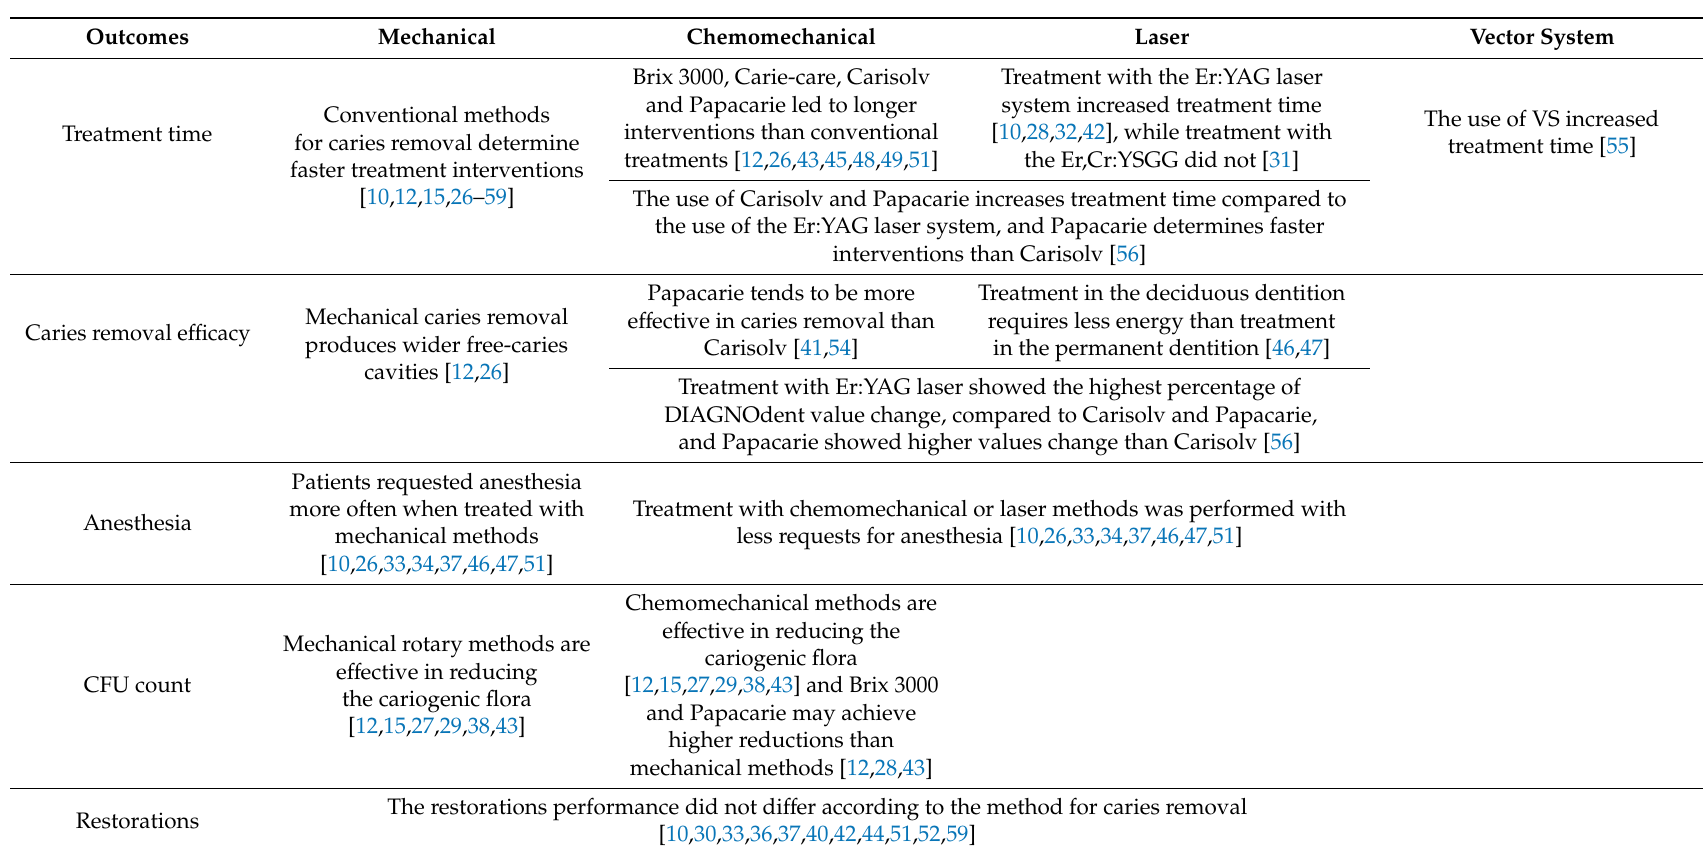
Table 7. Summary